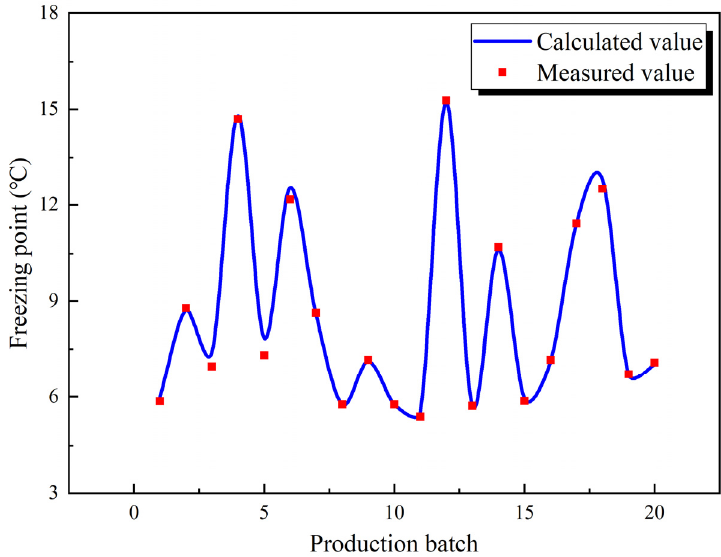
Figure 3. Comparison between calculated value and measured value of freezing point.